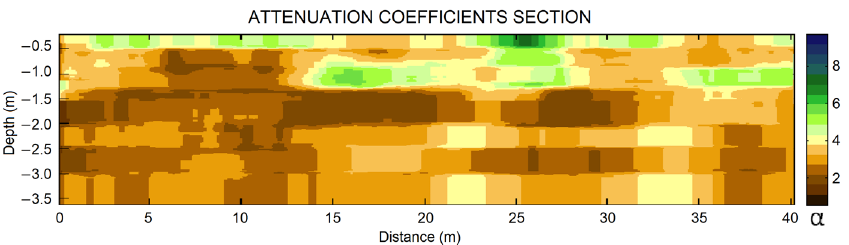
Figure 14. Example of a section showing the variation in attenuation coefficient values obtained from GPR profile.